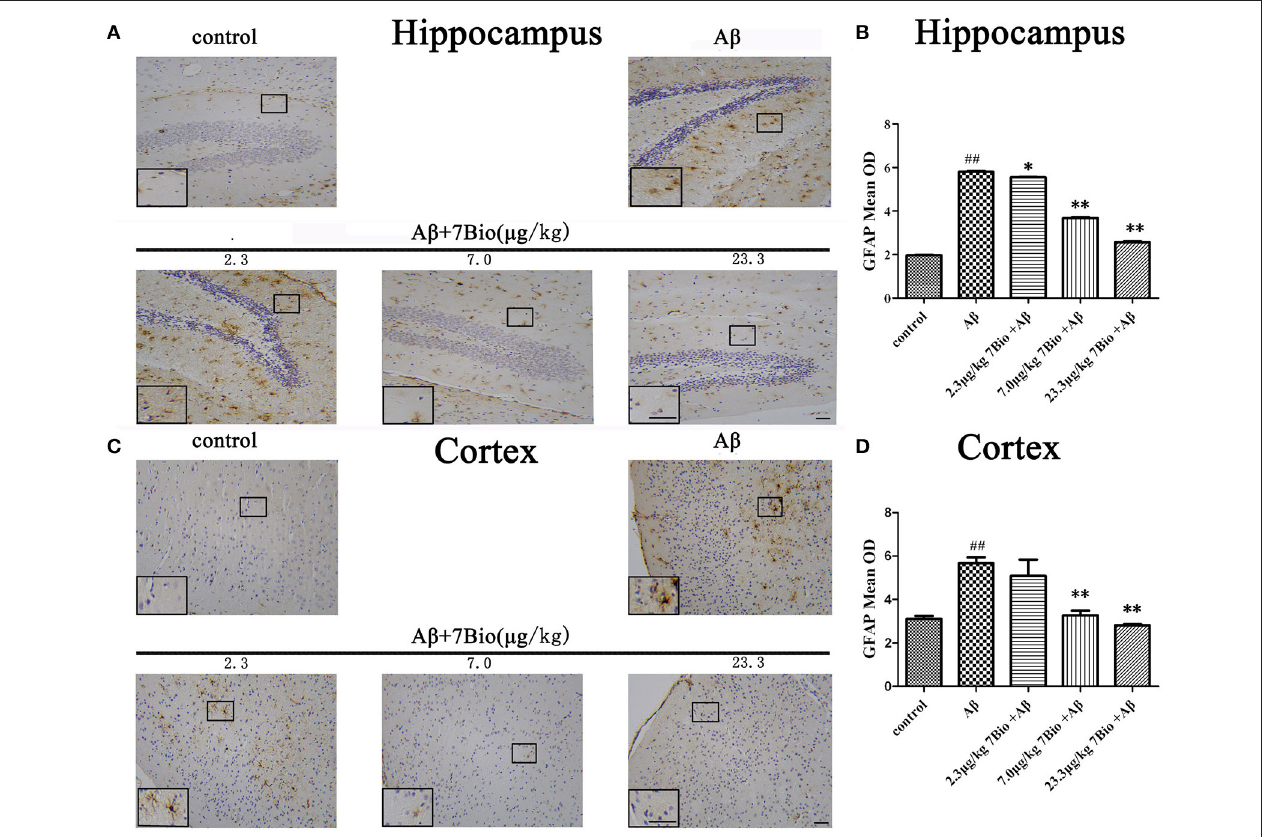
FIGURE 10 | 7Bio attenuates A β oligomer-induced increased of GFAP in the hippocampal and cortical region of mice. (A) Representative figures of IHC staining of GFAP in the hippocampal region in various groups as indicated. (B) Quantitative results showed that 7Bio decreased mean OD of GFAP in the hippocampal region of mice. (C) Representative figures of IHC staining of GFAP in the hippocampal region in various groups as indicated. (D) Quantitative results showed that 7Bio decreased mean OD of GFAP in the cortical region of mice. Data represent the mean ± SD ( n = 3); ## p < 0.01 vs. control group, * p < 0.05 and ** p < 0.01 vs. A β group (one-way ANOVA and Tukey’s test). Scale bar: 30 µ